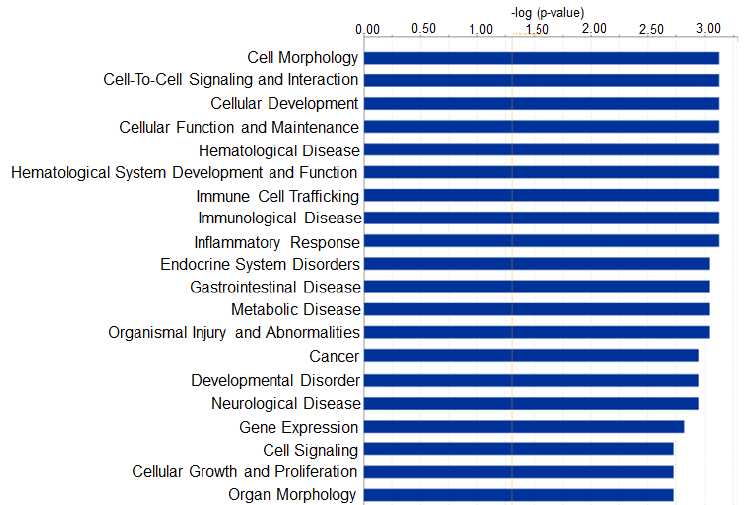
Figure 4. Bar graph indicating the number of miRNAs that are predicted to target genes in each category listed on the x -axis. Here, Ingenuity Pathway Analysis (IPA) provides information about which pathways can potentially be influenced by the top miRNAs.